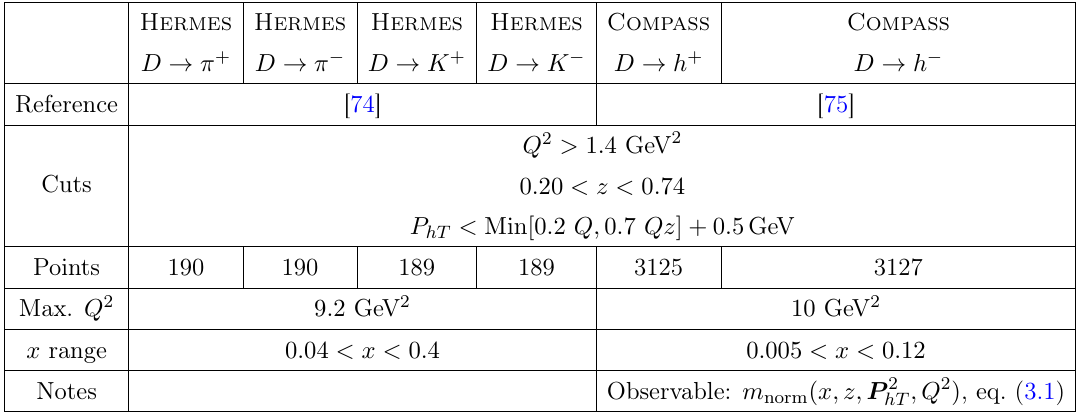
Table 2 . SIDIS deuteron-target data ( Hermes and Compass experiments).